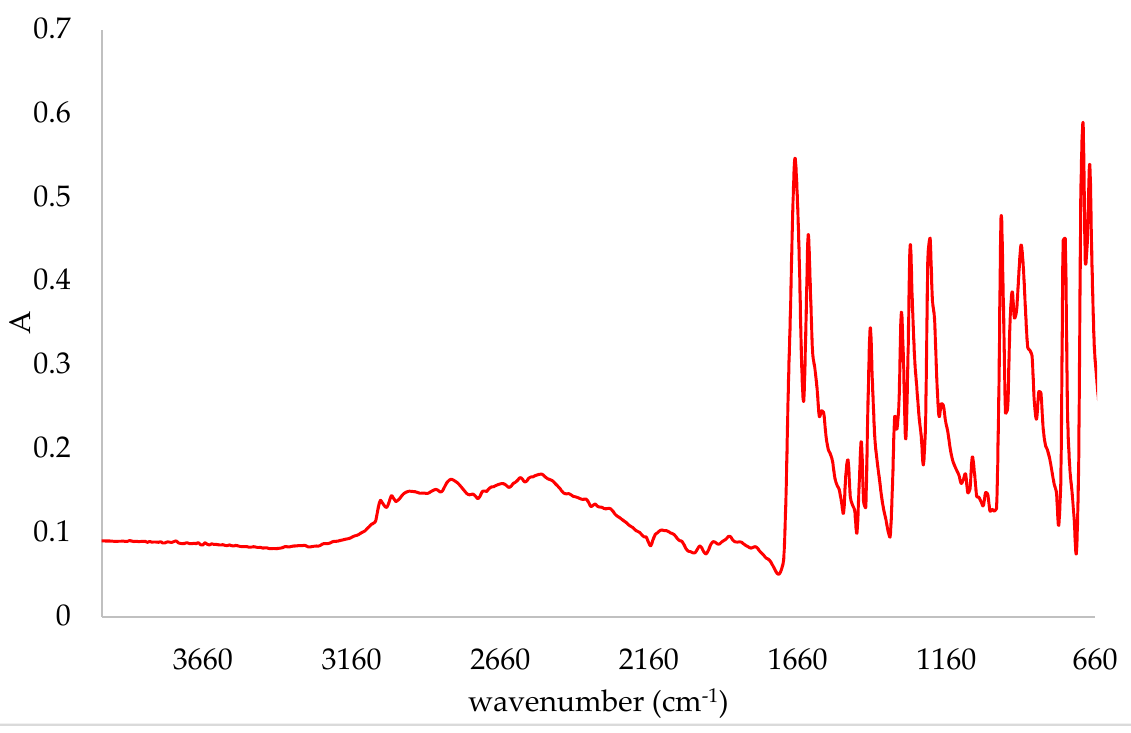
Figure 3. IR spectra of pumpkin protein (PuP) and obtained complexes with cinnamic acid (PuP_10%CA—complex prepared with 10% of protein matrix; PuP_1%CA—complex prepared with 1% of protein matrix).